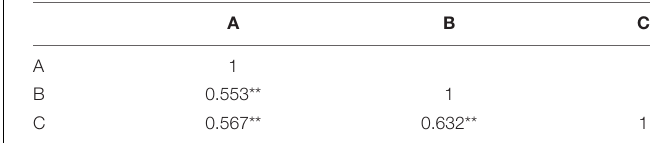
TABLE 2 | The validity of the